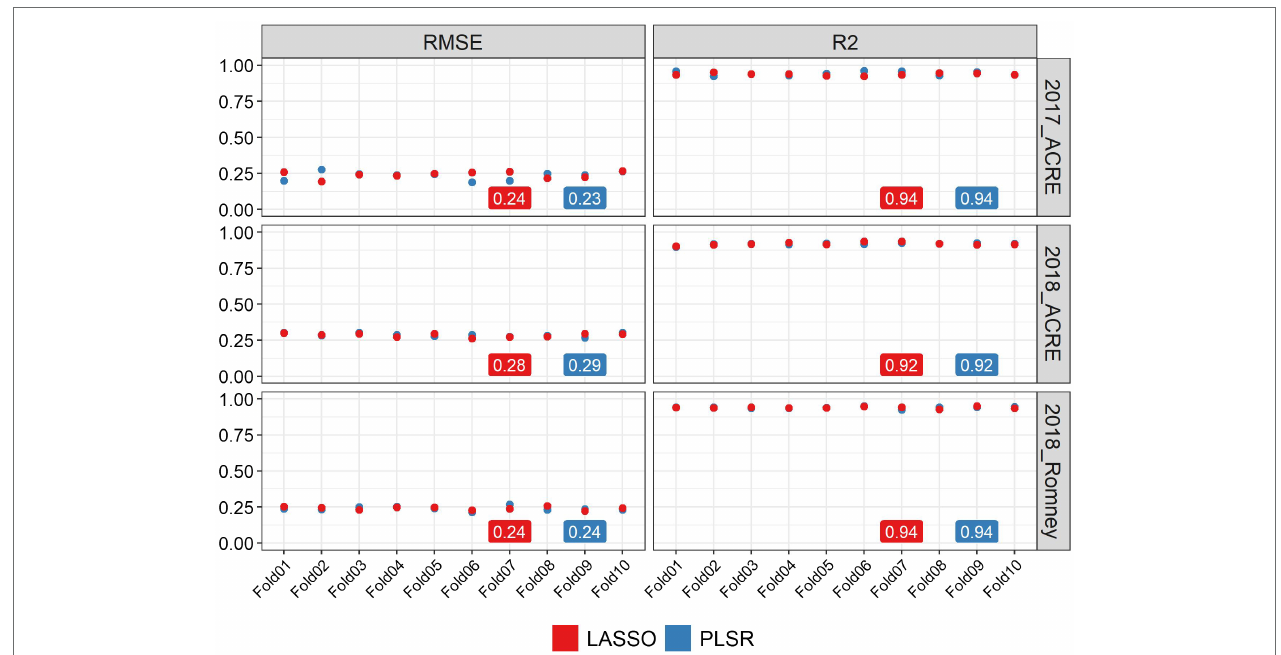
FIGURE 2 | Performance of above-ground biomass prediction for each environment. Predictions were performed using the least absolute shrinkage and selection operator (LASSO) regression, and the partial least squares regression methods. The performance of predictions was evaluated using the root mean squared error (RMSE) and coefficient of determination (R2), using a 10-fold cross-validation set. The y-axis represents the values for RMSE and R 2 and x-axis indicates each cross-validation